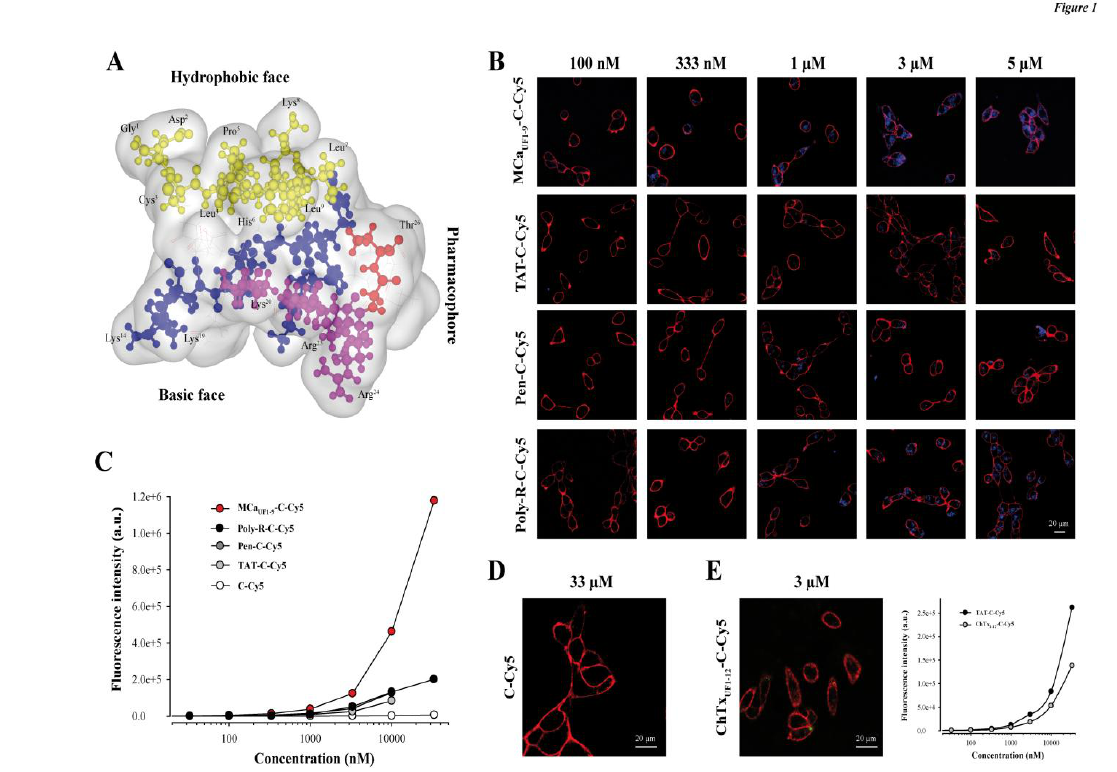
Figure 1 . The hydrophobic domain of MCa is an efficient CPP. ( A ) Schematic representation of MCa 3D structure. The hydrophobic domain (from amino acid residue 1 to 9) is shown on top. Residues are in yellow. Shown also are the basic face (basic amino acid residues are in blue or in pink) and the pharmacophore (residues identified as interacting with the ryanodine receptor are in red or in pink). Pink residues belong both to the pharmacophore and the basic face. ( B ) Confocal microscopy images illustrating the penetration of four different peptides labeled with Cy5 at various concentrations into glioma F98 cells (blue color). Incubation times were 2 h for each peptide/concentration. Images were taken immediately after washout of the extracellular peptide. The plasma membrane is labeled with concanavalin-A-rhodamine (red color). ( C ) Dose-dependent penetration of each peptide-cargo complex in F98 cells as assessed by flow cytometry. A control Cys-Cy5 is also provided. ( D ) Absence of cell penetration of 33 µM Cys-Cy5 (a single Cys residue linked to Cy5—abbreviated C-Cy5) evaluated by confocal microscopy. ( E ) Lack of cell penetration of 3 µM ChTx -C-Cy5 as determined by confocal UF1-12 microscopy (right panel). Quantitative analysis of F98 ChTx -C-Cy5 fluorescence as UF1-12 determined by flow cytometry. Internalization of the ChTx -C-Cy5 peptide is lower UF1-12 than TAT-C-Cy5 but not